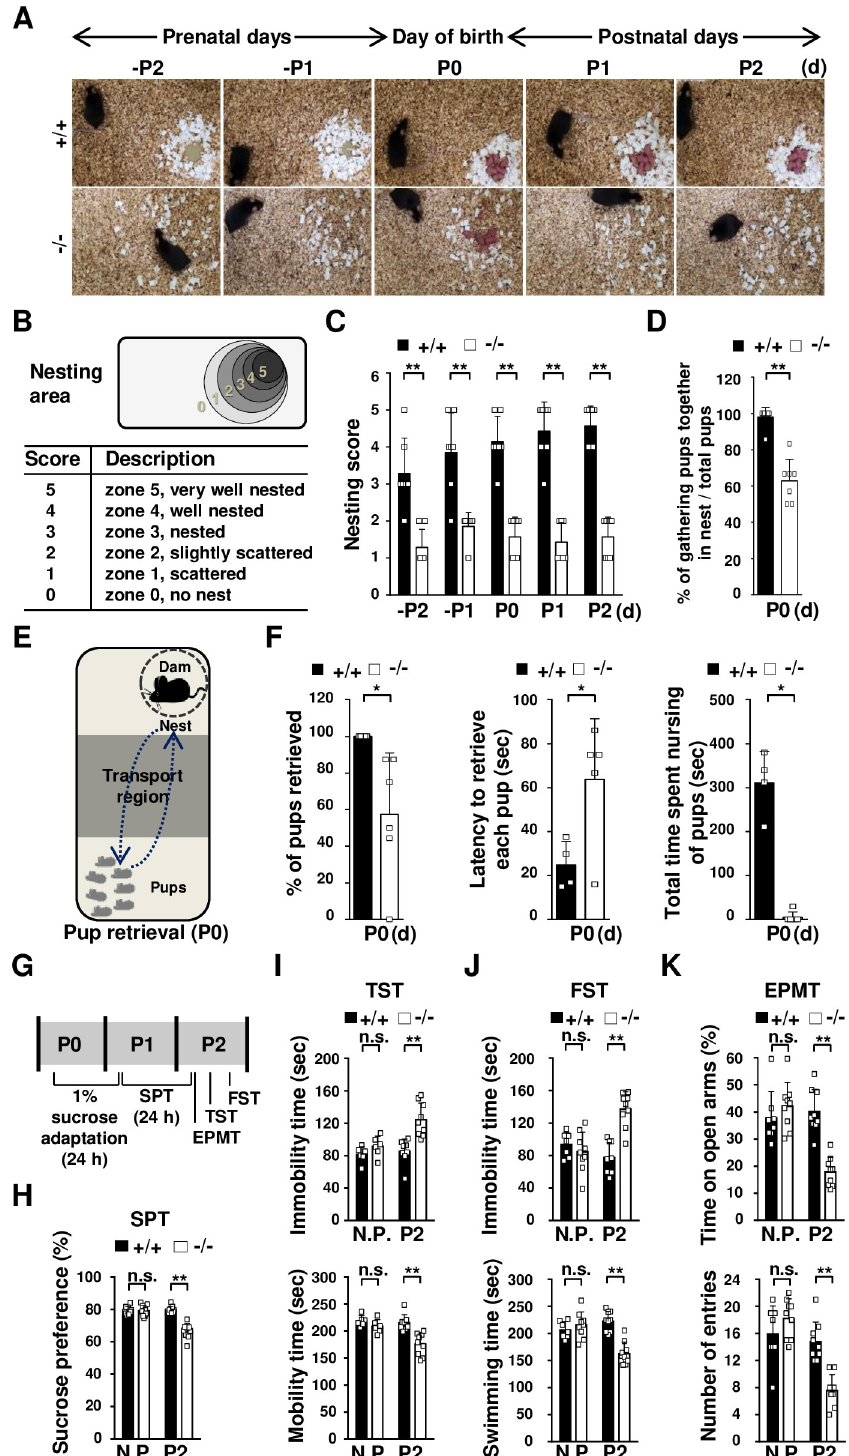
Fig 2. TDAG51 deficiency elicits abnormal maternal behavior and depressive-like behavior after parturition. (A) Reduced nest building ability in TDAG51 -/- female mice. TDAG51 +/+ or TDAG51 -/- female mice with vaginal plugs were separated from their male mating partners and given nesting material on prenatal day 3 (-P3). Photographs of nest building were obtained from -P2 to P2. +/+, TDAG51 +/+ dams. -/-, TDAG51 -/- dams. (B) Diagram of the measurement of the nest building score. Nesting scores (0–5) indicate the extent of nest building. (C) TDAG51